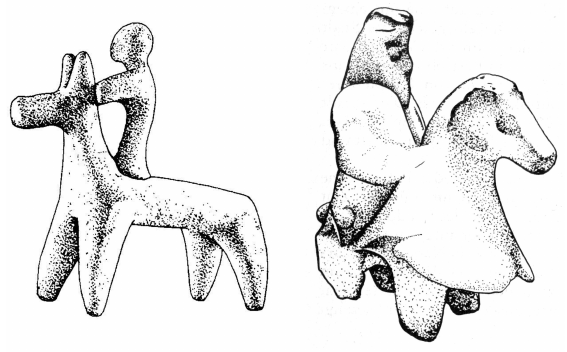
Figure 11 Judean horse and rider figurine (Lachish, Iron Age IIC) and a so-called Persian rider (Tel Erani, Persian